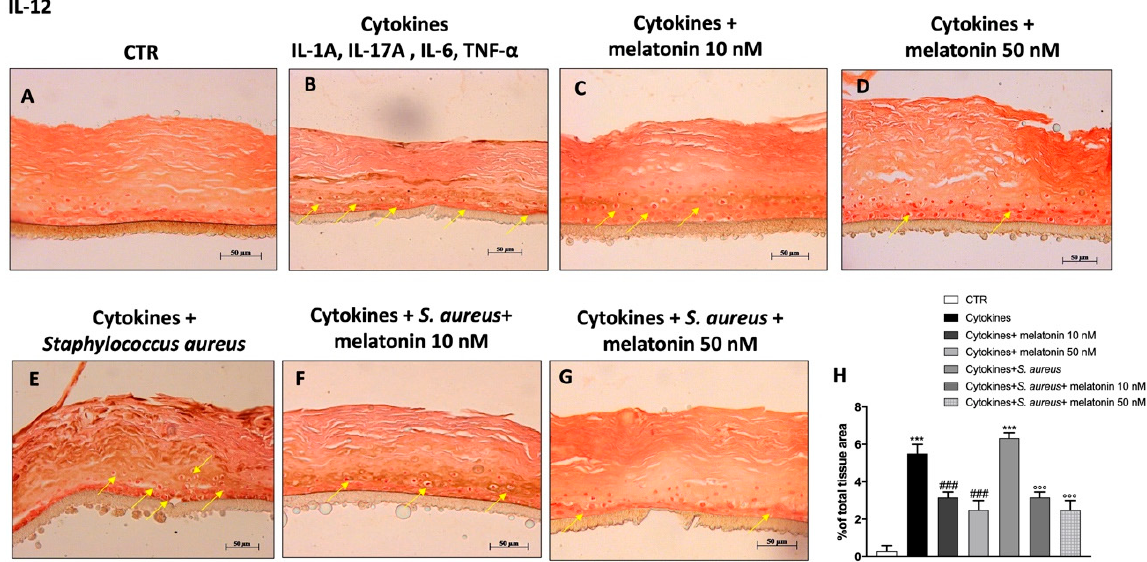
Figure 9. Effect of melatonin on IL-12 expression. Immunohistochemical staining revealed that the cytokines and S. aureus groups were characterized by an increase of IL-12 expression compared to the control group ( A , B , E ); however, melatonin treatment 10 nM and 50 nM significantly reduced its expression ( C , D , F , G ). The yellow arrows indicate the positive staining. Data are representative of at least three independent experiments. ( H ) *** p < 0.001 vs. CTR; ### p < 0.001 vs. cytokines group. ◦◦◦ p < 0.001 vs. cytokines + S. aureus